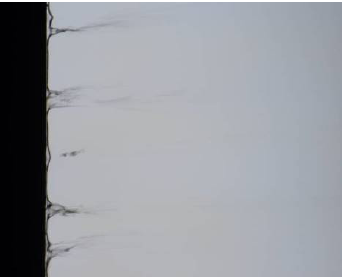
Fig. 4. The droplets formation on the trailing edge of the profile in the wind tunnel.